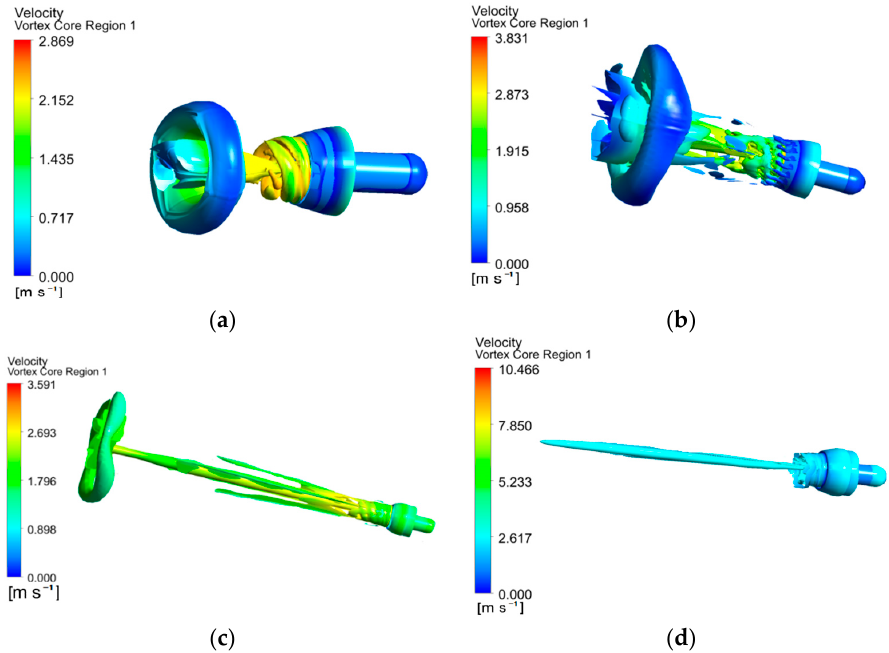
Figure 10. Vorticity distribution of different navigational speed with 2000 r/min impeller rotational speed. ( a ) 0 m/s; ( b ) 0.37 m/s; ( c ) 1.54 m/s;( d ) 2.057 m/s.